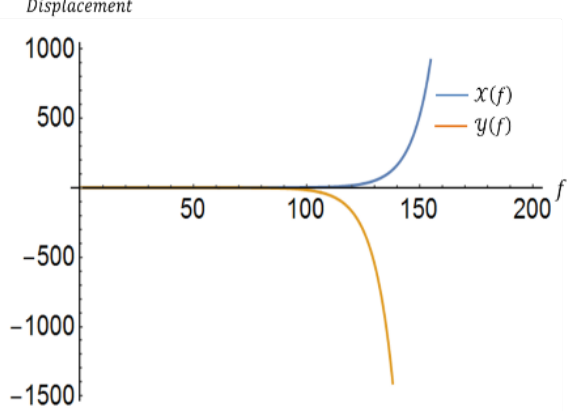
Figure 8. The growth of a small displacement for a test particle placed at L 3 vs. f .